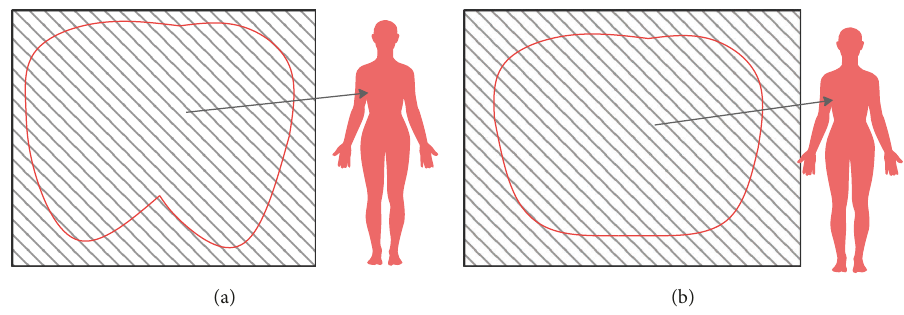
Figure 3: The outline of the thoracic section. (a) Thoracic section outline. (b) Bust line.